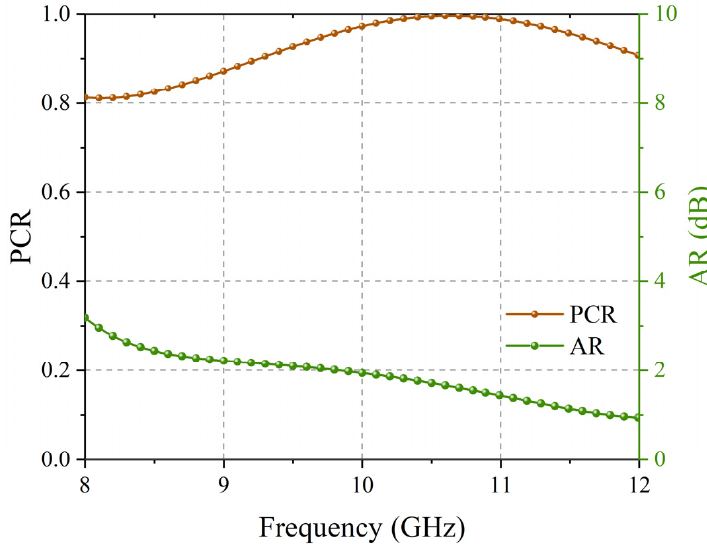
Figure 5. The simulated PCR and AR .